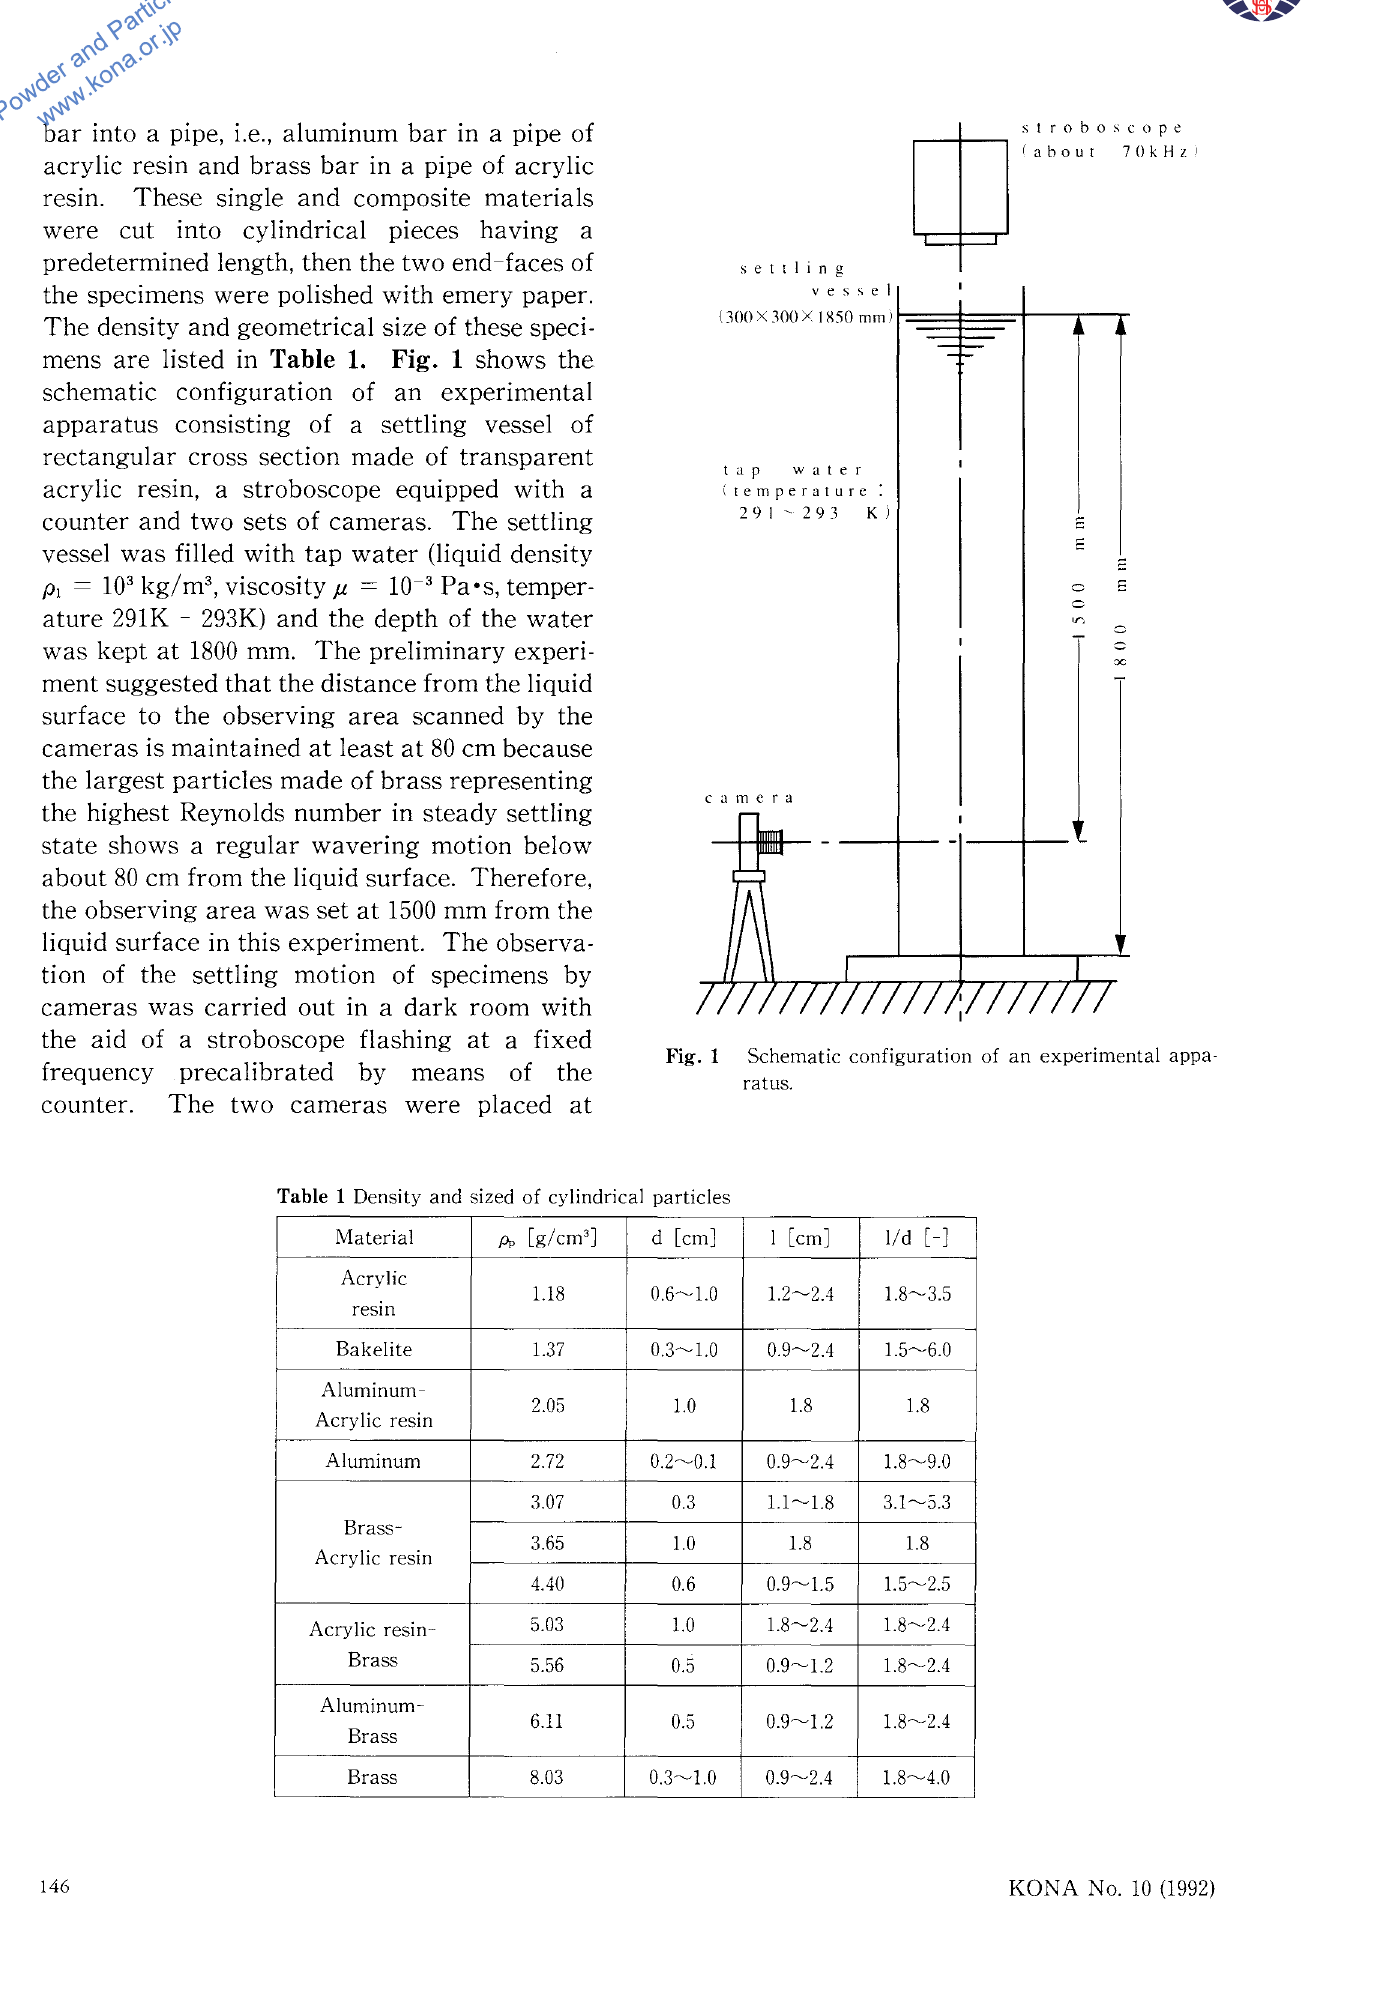
Fig. 1 Schematic configuration of an experimental appa ratus.